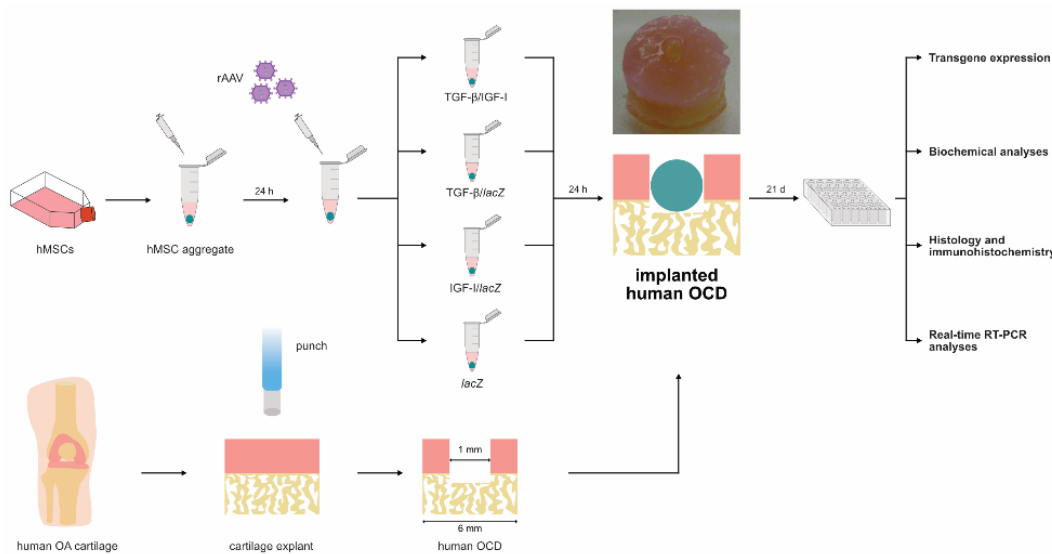
Figure 1. Study design. Human bone marrow-derived mesenchymal stromal cells MSCs were prepared as high-density aggregates (2 × 10 5 cells / aggregate) in defined chondrogenic medium overnight, transduced with the various rAAV shuttles (TGF- β / IGF-I, TGF- β / lac Z, IGF-I / lac Z: 40 µ L each vector / aggregate; lacZ : 80 µ L vector / aggregate), and directly applied to human osteochondral defects (OCDs; 6-mm diameter) for further culture in defined chondrogenic medium for 21 days when the OCDs were processed to monitor transgene expression and for biochemical, immunohistochemical / histological, and real-time